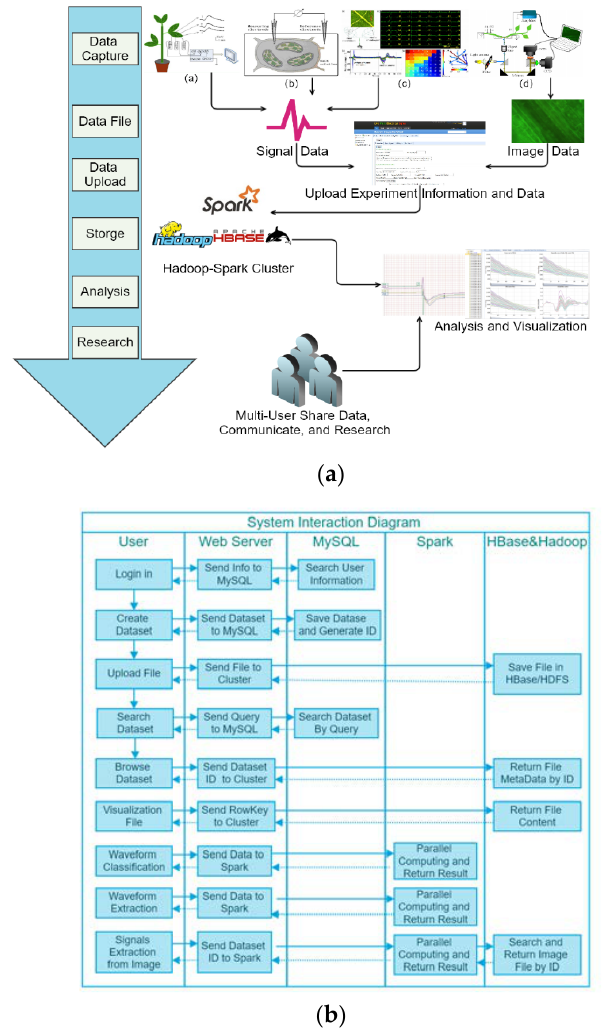
Figure 2. Overview of the web system functions. ( a ) A workflow of plant electrophysiological data management and analysis in the web system. ( b ) The system interaction diagram among different modules.